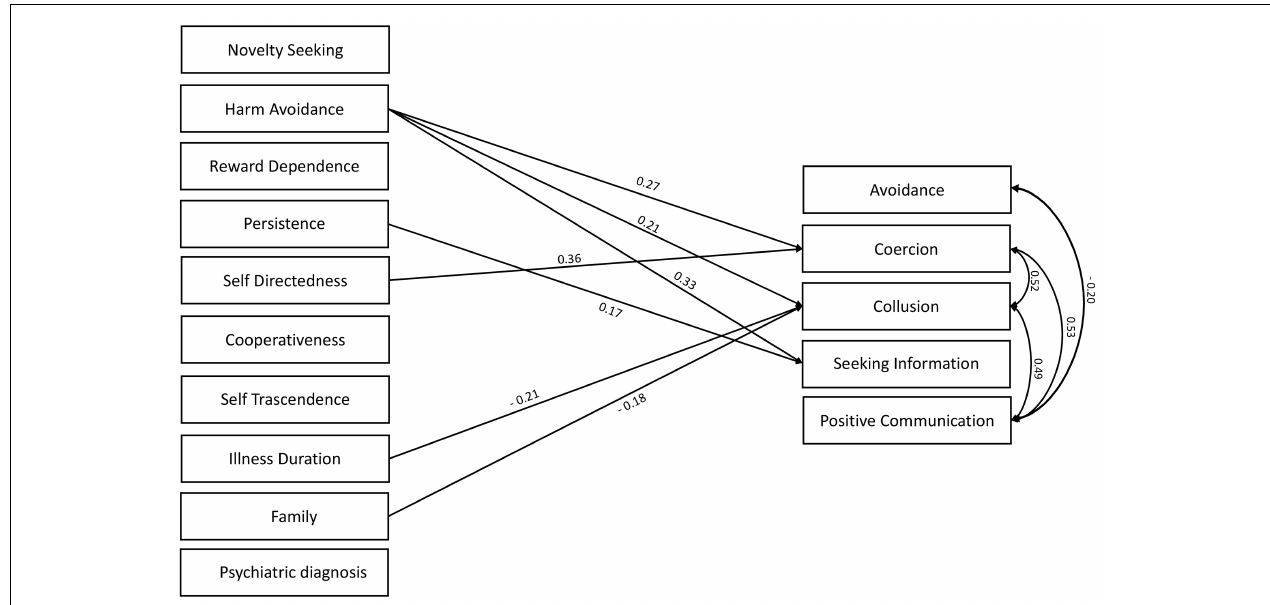
FIGURE 2 | Multivariate regression analyses in the sample of mothers. Standardized beta is reported on the arrows (df =